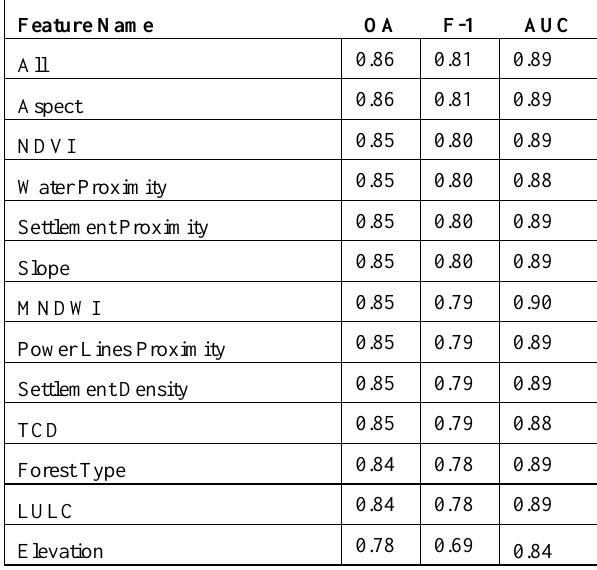
Table A2 . Leave-one-out results of the